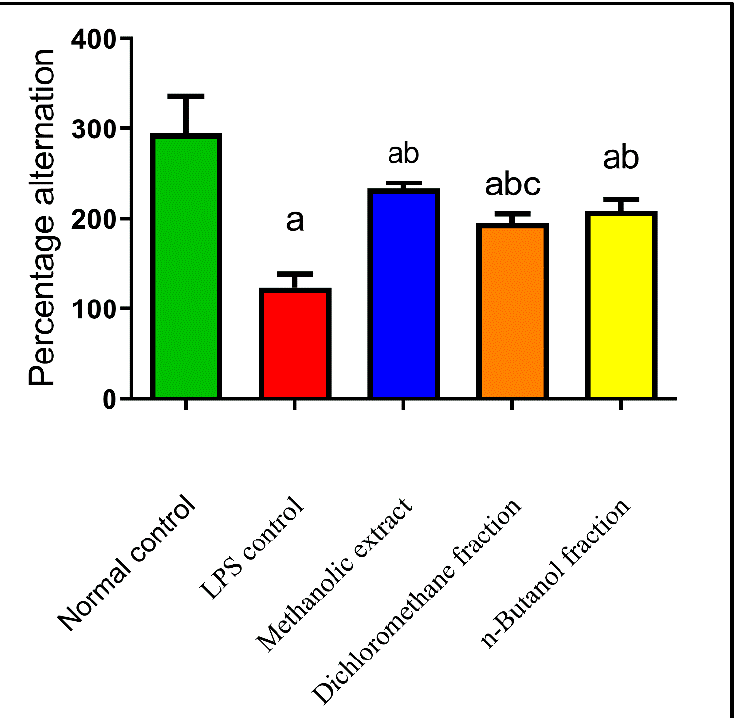
Figure 3. Effects of BME, BDMF, and BBF on behavioral activity on Y-maze in LPS-induced Alzheimer in mice. Data are presented as the mean ± standard error (SE) of n = 8 per each group. Statistical analysis was done using one-way analysis of variance followed by Fisher’s LSD test. a Statistically significant from normal control at p < 0.05. b Statistically significant from LPS control at p < 0.05. c Statistically significant from BME at p < 0.05. BME: B. armeniaca methanolic extract; BDMF: B. armeniaca dichloromethane fraction; BBF: B. armeniaca butanol fraction; LPS: